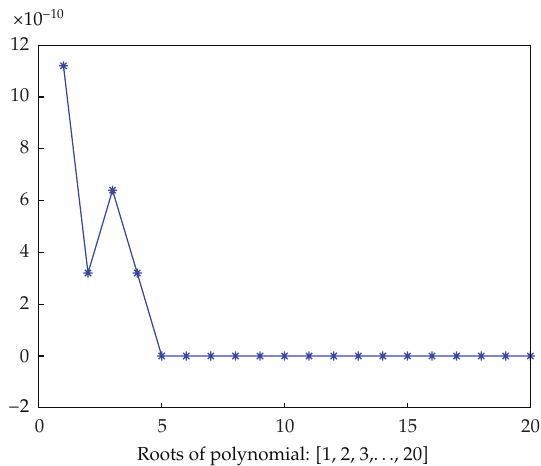
Figure 1: Error of Schmeisser-Fiedler method Wilkinson polynomial.